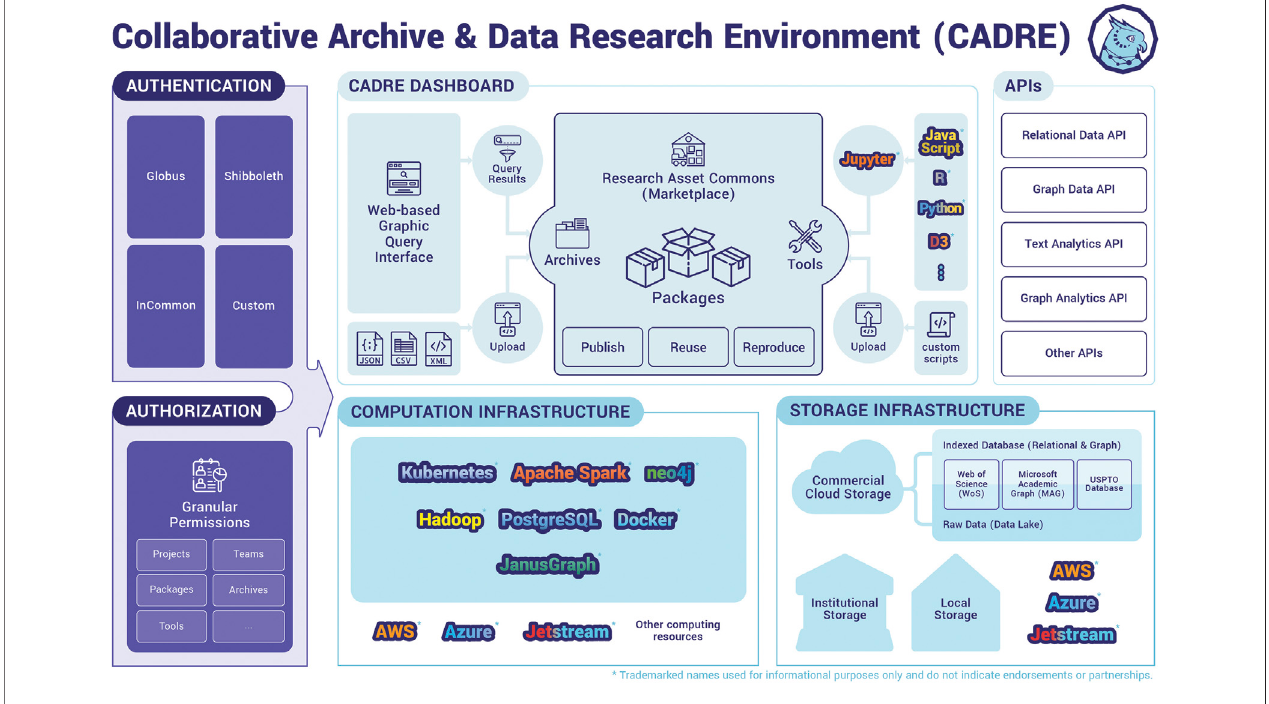
FIGURE 2 | Envisioned blueprint of the CARE platform.